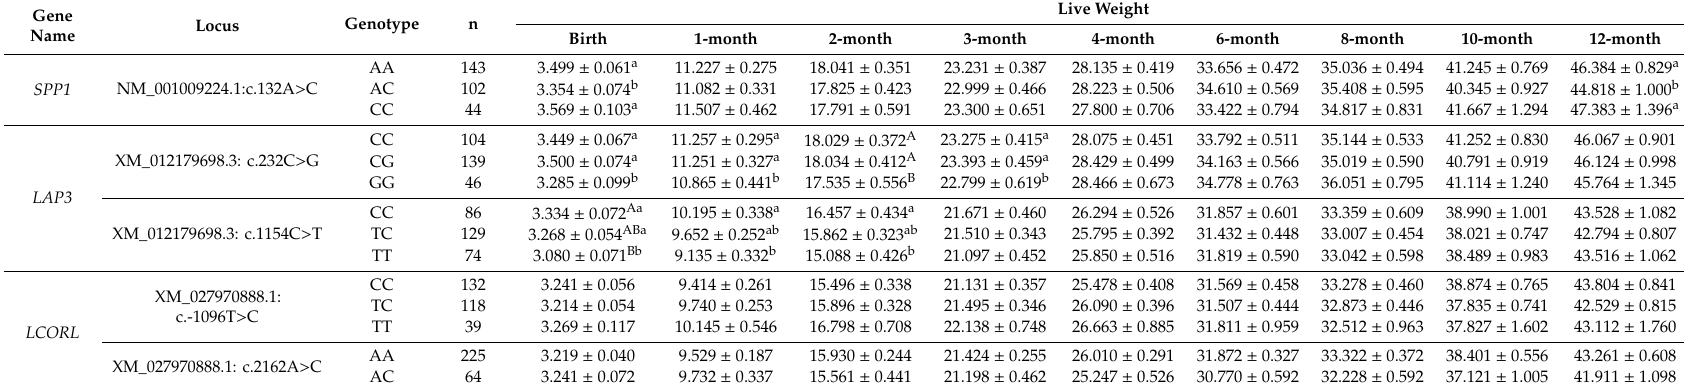
Table 2. Associations between the genotypes of the single nucleotide polymorphisms (SNPs) and body weight in the experimental